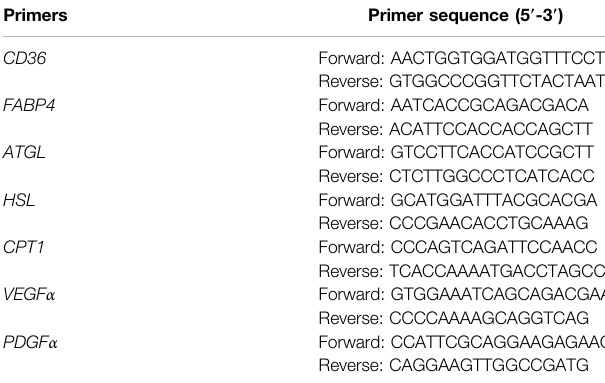
TABLE 1 | The primers of genes.